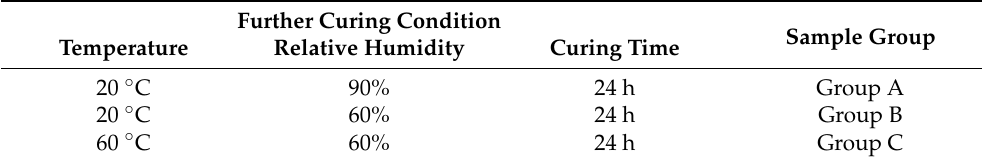
Table 2. Conditions for further curing of concrete